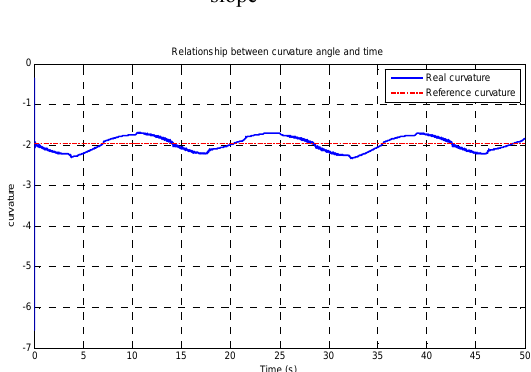
Fig.9. Comparison of real curvature and reference curvature on 6 degree